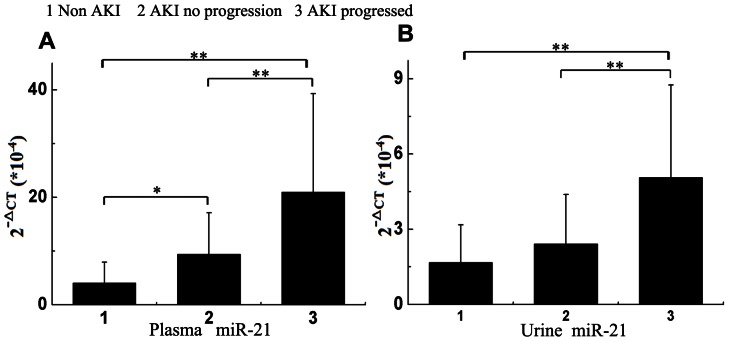
Comparison of plasma and urine microRNA-21 levels in patients with AKI and in non-AKI controls.Expression of miR-21 in EDTA-plasma (A) and urine (B) obtained from patients with progressing AKI (n = 39), AKI without progression (n = 41) and non-AKI controls (n = 40) as determined by TaqMan PCR. Levels of miR-21 were expressed as the 2−Δct value, multiplied by 10−4. After post hoc analysis, only the association urinary miR-21 levels between non-AKI and non-progressive AKI groups failed to reach statistical significance (P = 0.19). *P<0.05 and **P<0.0001.